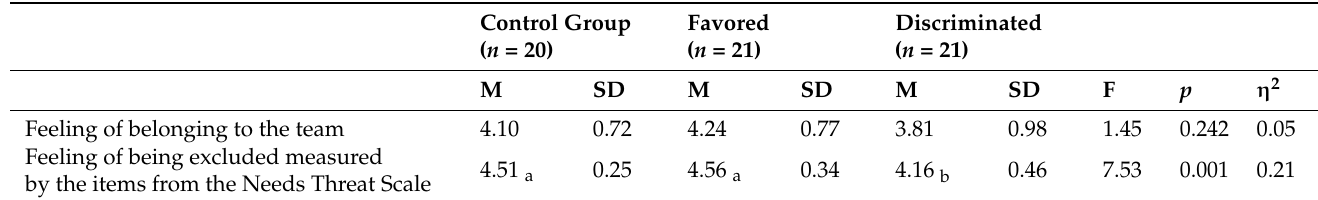
Table 4. Comparison of different groups for the feeling of belonging to the team and the feeling of being excluded from the team.